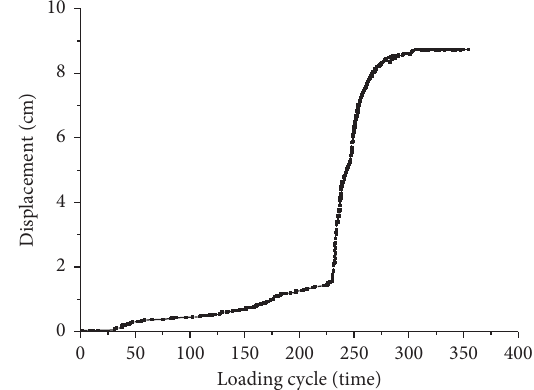
Figure 8: Relationship between pad displacement and the loading